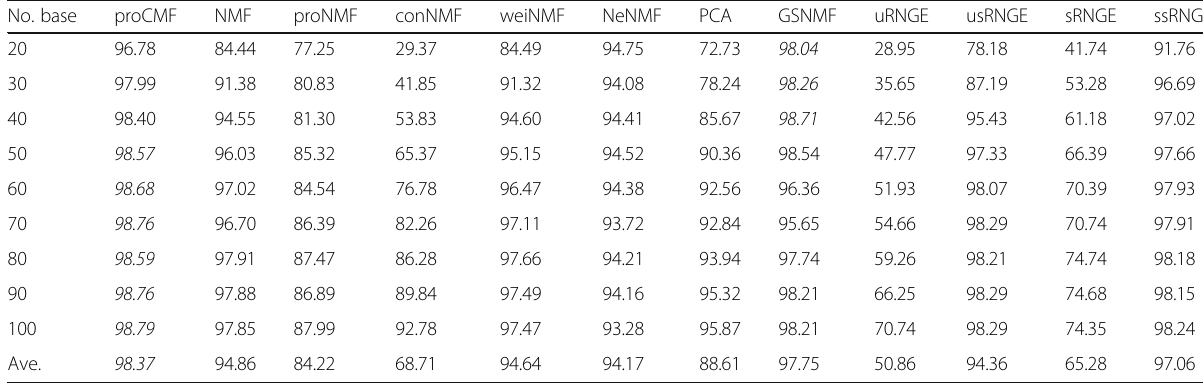
Table 2 Facial expression recognition rate (%) using the CK+ dataset with different subspace dimensionalities (case 2: no. training = 2) No.